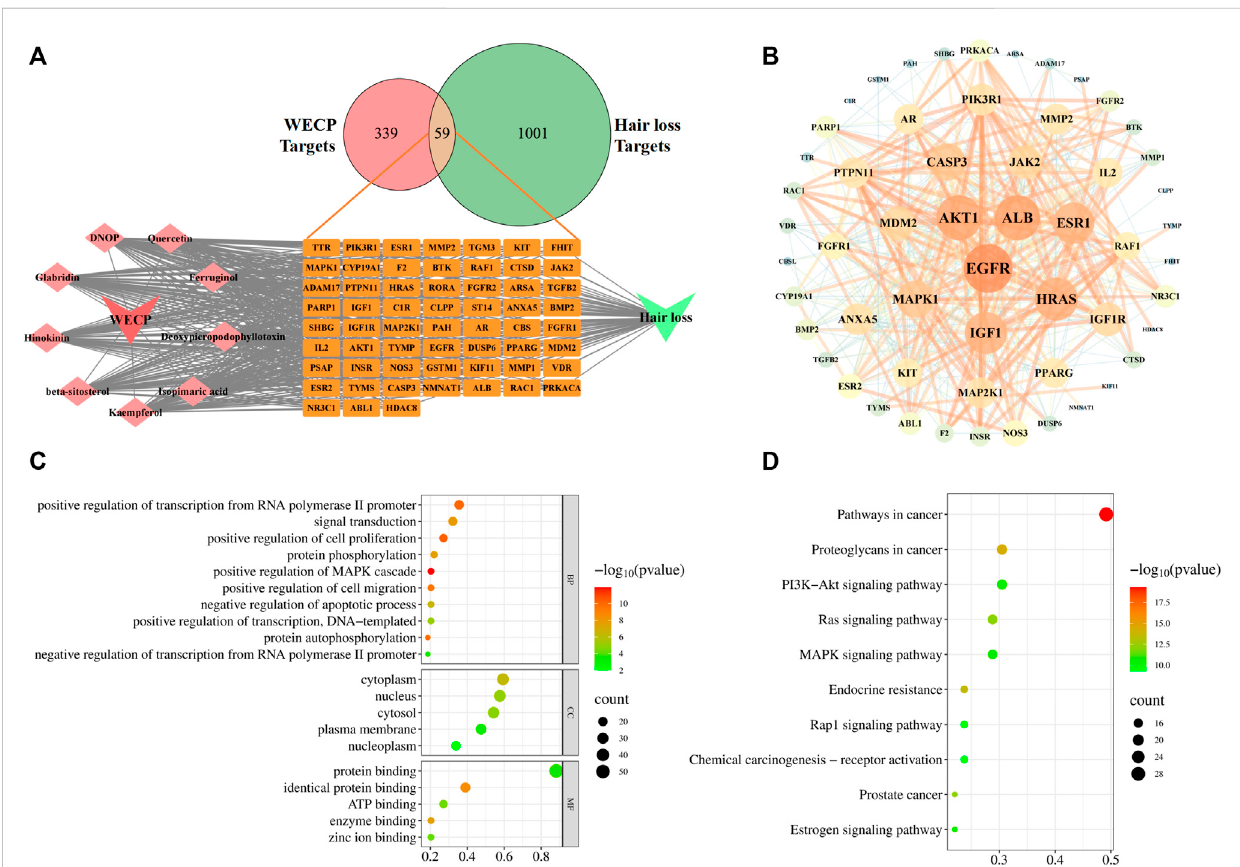
Network analysis of WECP. (A) Venn diagram showing 59 predicted WECP targets in hair loss and ingredients-targets-disease network of WECP. (B) PPInetworkof59predictedtargetsvisualizedwithCytoscapev.3.7.1.Targetsizeandcolorarebasedondegreevalues.Functionalenrichmentanalysisof WECP. (C) GO enrichment analysis of 59 predicted targets. (D) KEGG enrichment analyses of 59 predicted targets. Horizontal axis represents the proportion of enriched genes in terms. Vertical axis represents each term. Dot size and color represent the number of enrichment targets and p -values,